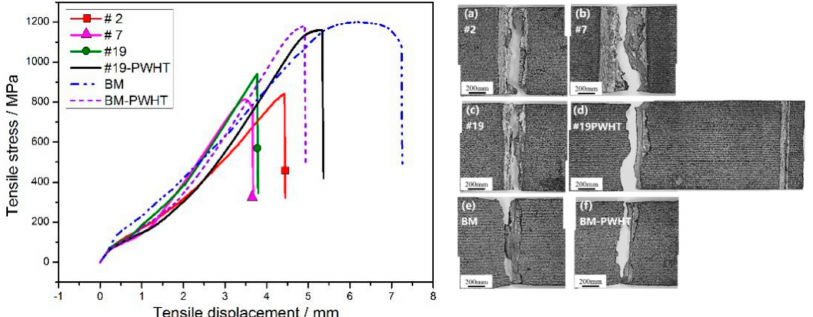
Figure 12. The stress–tensile displacement curve and fracture morphologies of Ti55531 laser welded. ( a ) #2: P = 2 kw, v = 2 m/min, f = 0 mm; ( b ) #7: P = 2.5 kw, v = 2 m/min, f = +3 mm; ( c ) #19: P = 3.5 kw, v = 4 m/min, f = 0 mm; ( d ) #19 after PWHT, ( e ) BM and ( f ) BM after